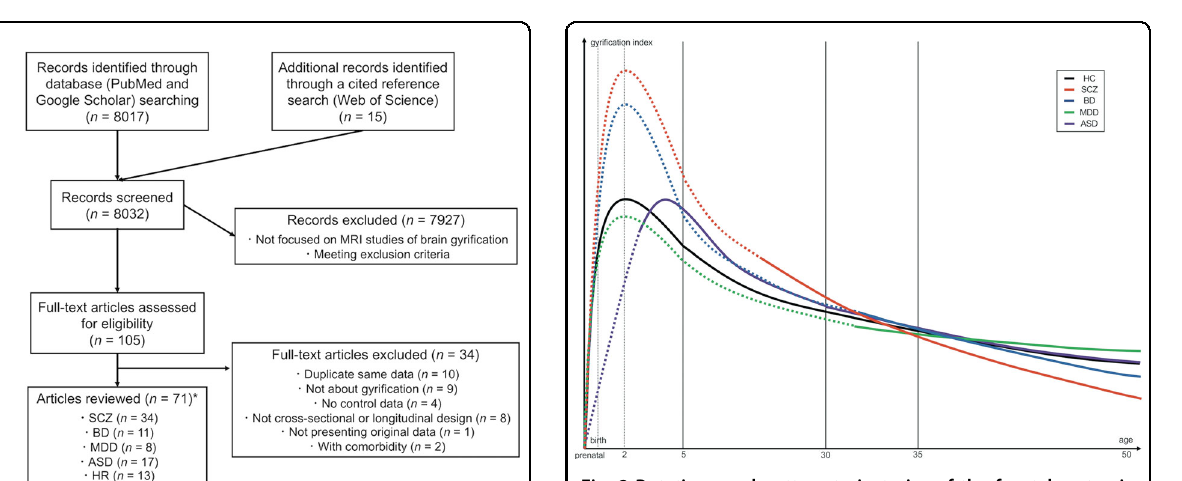
Fig. 2 Putative gyral pattern trajectories of the frontal cortex in major psychiatric disorders. Dotted line: Presumed trajectory of gyri fi cation pattern suggested from fi ndings reported in neighboring developmental periods and other indicators (e.g., gene expression, gray matter volume, and white mater integrity); Solid line: Dominant trajectory of gyri fi cation pattern based on previous gyral fi ndings being weighted according to the number of studies, sample size for studies, representativeness of cases, and methodological advantage to assess gyral patterns. ASD autism spectrum disorder, BD bipolar disorder, HC healthy controls, MDD major depressive disorder, SCZ